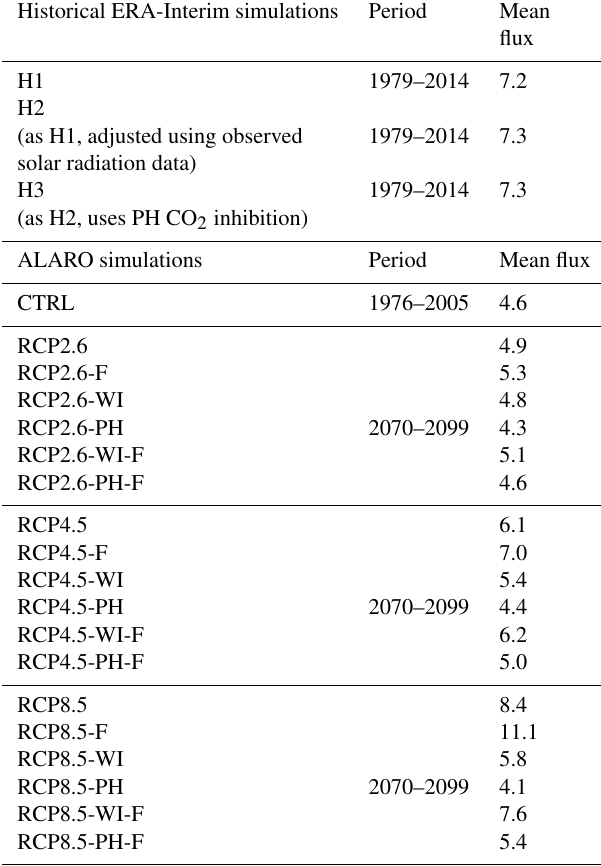
Table 1. Overview of performed simulations. The letter F denotes that the LAI response to CO 2 changes is accounted for based on Zhu et al. (2016) (see text). Simulations with WI account for CO 2 inhibition following Wilkinson et al. (2009) and those with PH fol- low the Possell and Hewitt (2011) parameterization. Mean isoprene flux over the given periods is expressed in teragrams of isoprene per